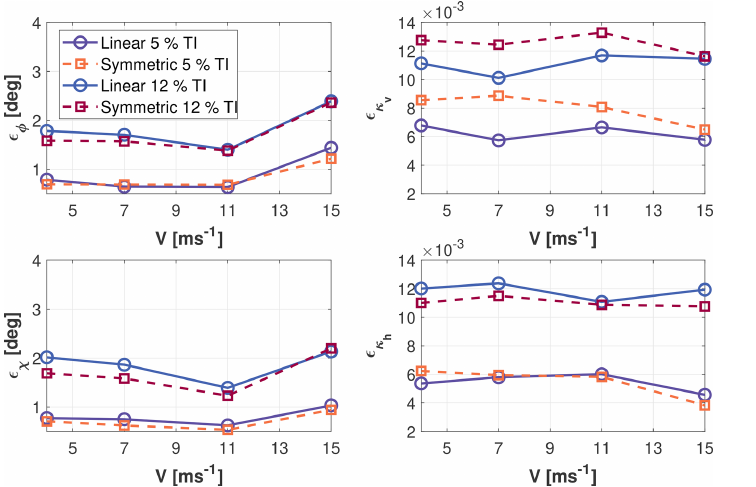
Figure 2. Mean absolute error (cid:15) of the four wind states vs. wind speed for 5% and 12% turbulence intensity (TI) levels. Nonsymmetric model: solid lines; symmetric model: dashed lines.